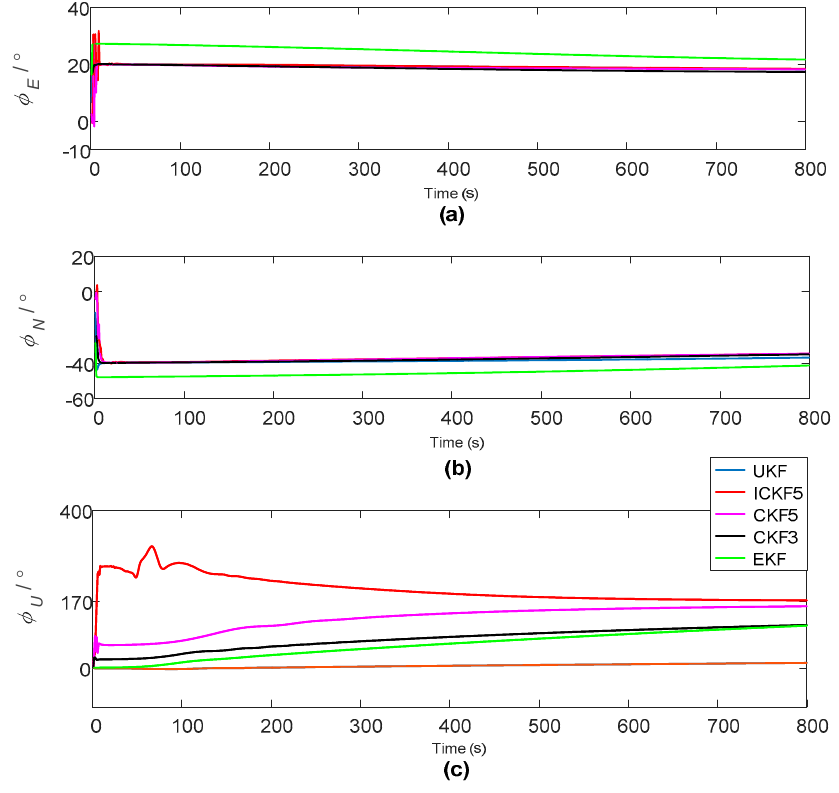
Figure 3. The estimated misalignment angles ( φ ( 0 ) = [ 20 ◦ , − 40 ◦ , 170 ◦ ] ): ( a ) Pitching misalignment angle; ( b ) rolling misalignment angle; ( c ) azimuth misalignment angle. The gradient values of the azimuth angle errors of ICKF5 are shown in Figure 4.